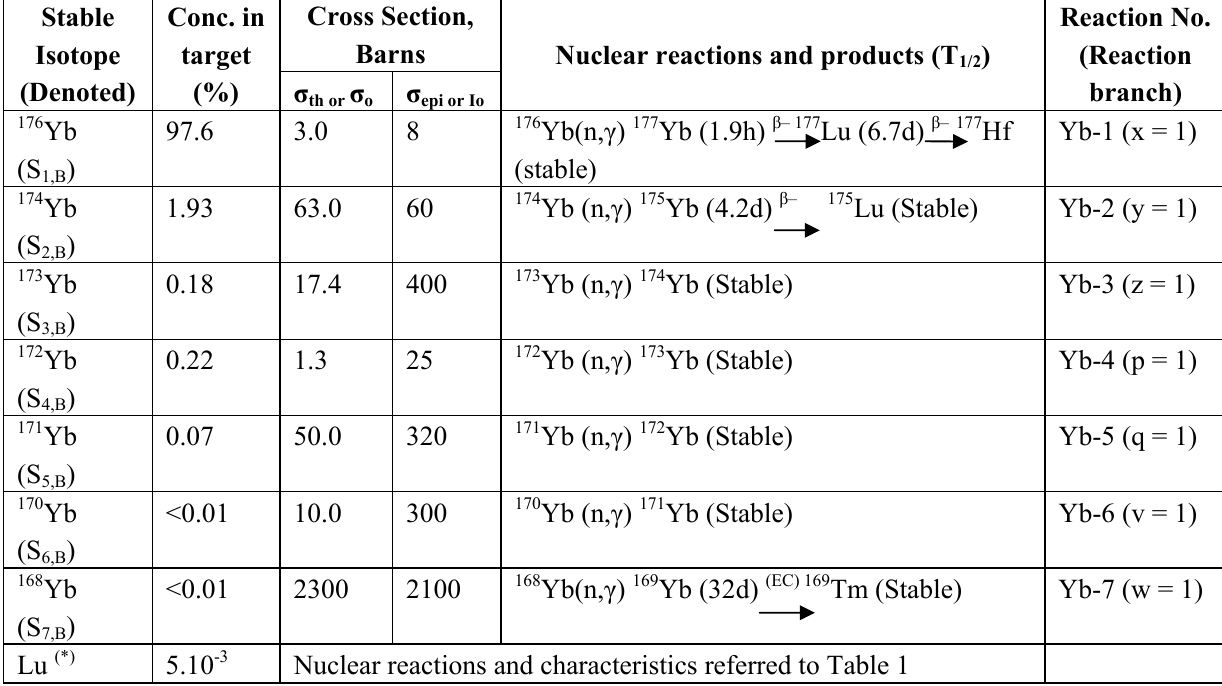
Table 2. Nuclear characteristics of radionuclides produced in 176 Yb target matrix [11].